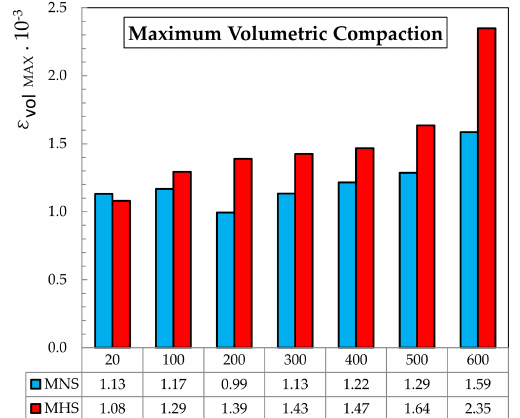
Figure 15. Uniaxial compression: Evolution with temperature of maximum volumetric compaction.